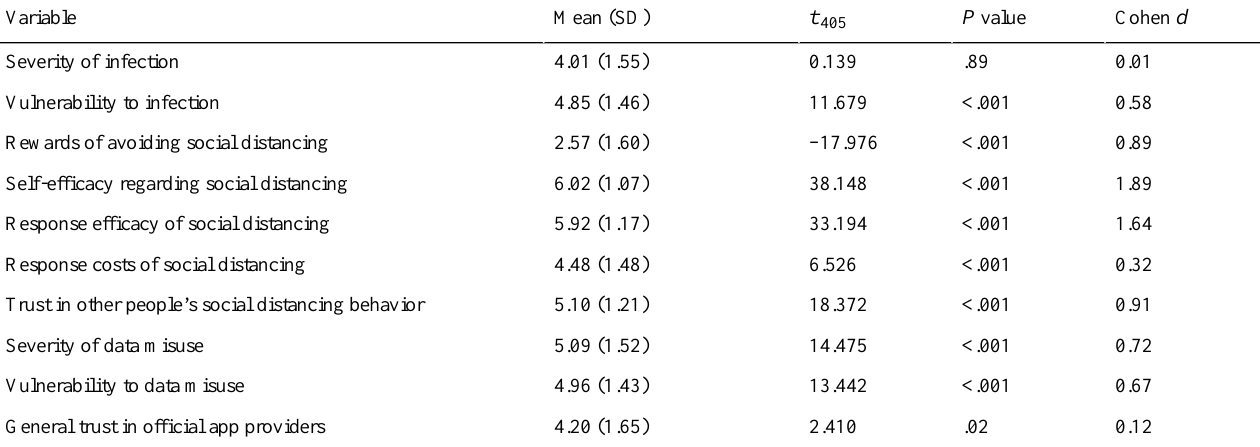
Table 2. Descriptive statistics and results of one-sample t tests against the scales’midpoint value (4) for independent variables of the regression models (age, gender, and day of participation were excluded due to the inappropriateness of the statistics in these